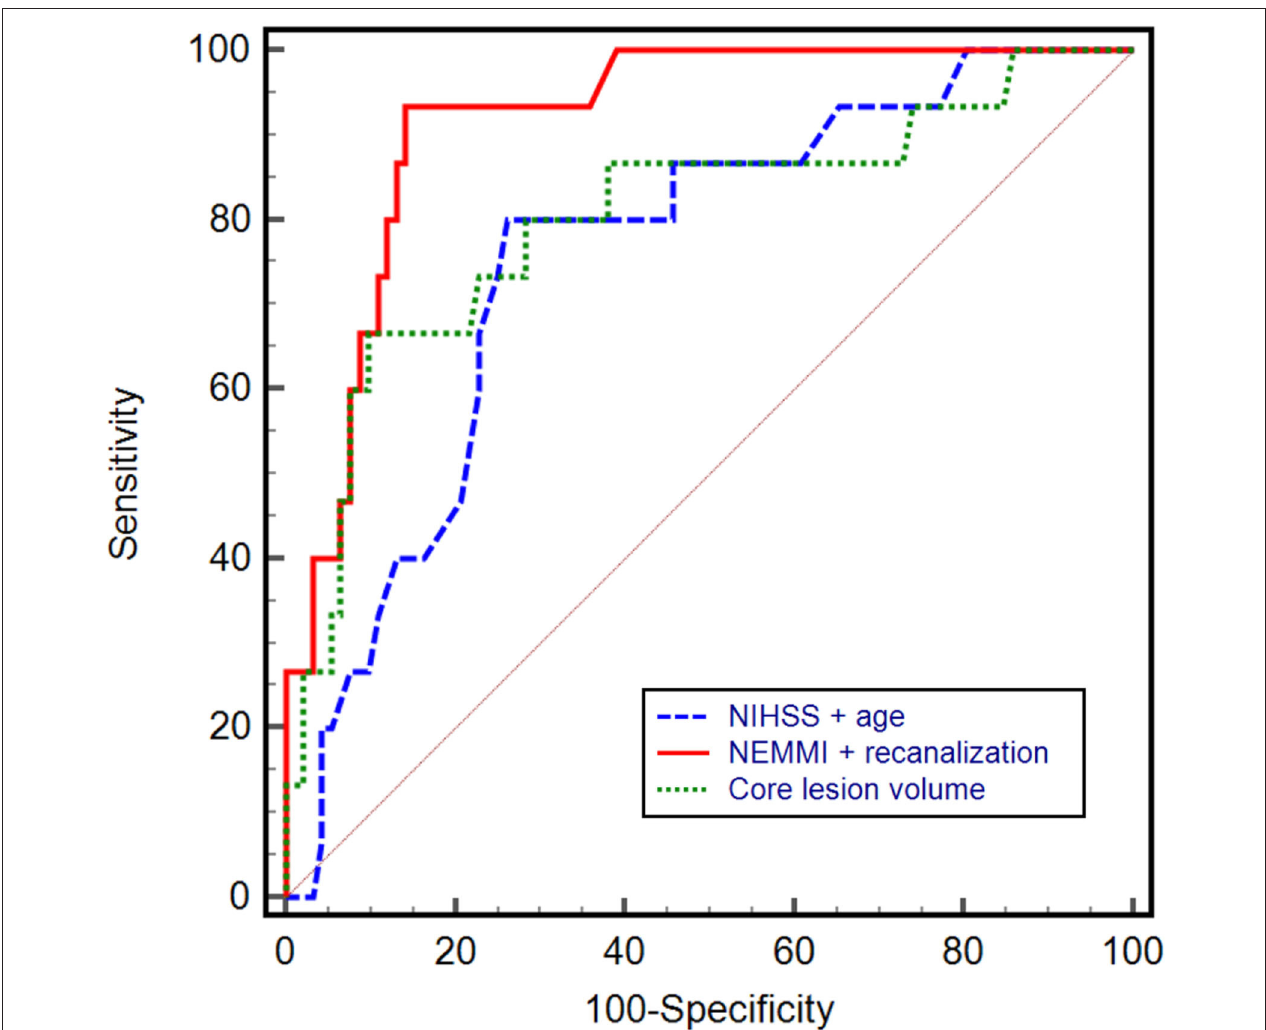
FIGURE 5 | Receiver operating characteristic (ROC) curves with the corresponding area under the curve (AUC) of different prediction models. A combined model including the NEMMI score and recanalization status demonstrated the highest diagnostic power (AUC: 0.92, 95%CI: 0.85–0.96), compared to the clinical model NIHSS + age (AUC 0.78; 95% CI 0.69–0.85) and core lesion volume (AUC 0.80; 95% CI 0.72–0.87). Not shown in the graph for reason of clarity: NEMMI score + age + recanalization (AUC 0.92; 95%CI 0.86–0.97); NIHSS + age + recanalization (AUC 0.89; 95%CI 0.81–0.94), NIHSS + recanalization (AUC 0.84; 95%CI 0.76–0.9).